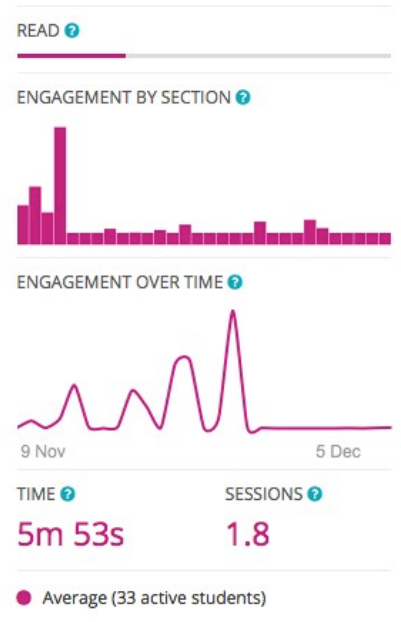
Figure 2. Lighthouse per-resource learning analytics